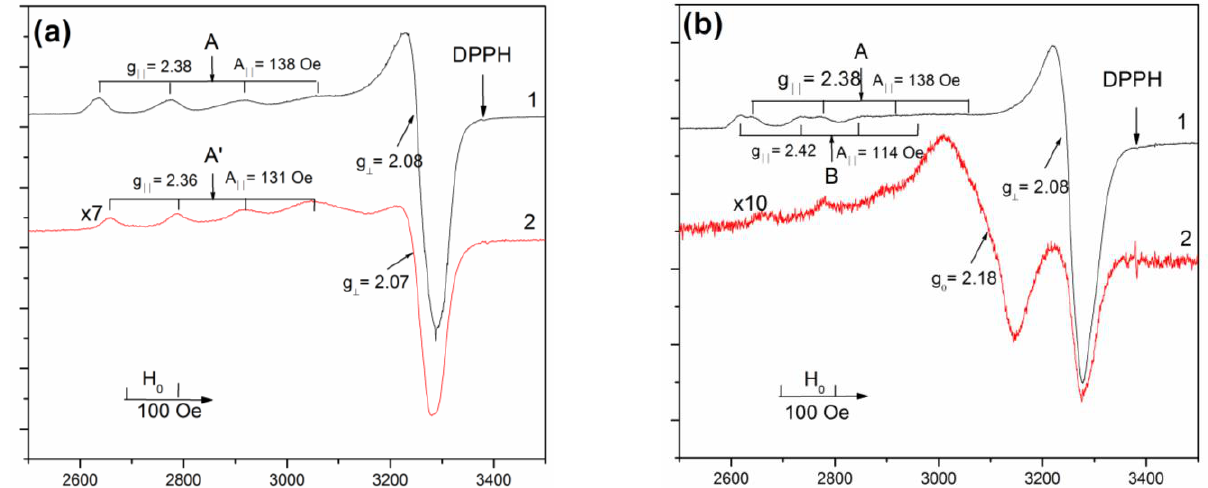
Figure 3. EPR spectra of Cu-MFI-SST samples recorded at − 196 °C (1) and 25 °C (2). Copper loadings are 1 ( a ) and 16 wt.% ( b ).